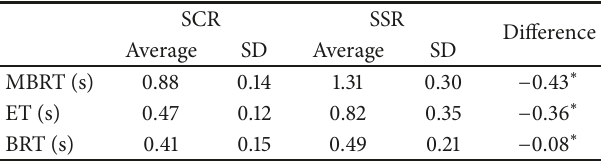
Table 12: Summary of drivers’ braking features in SCR and SSR